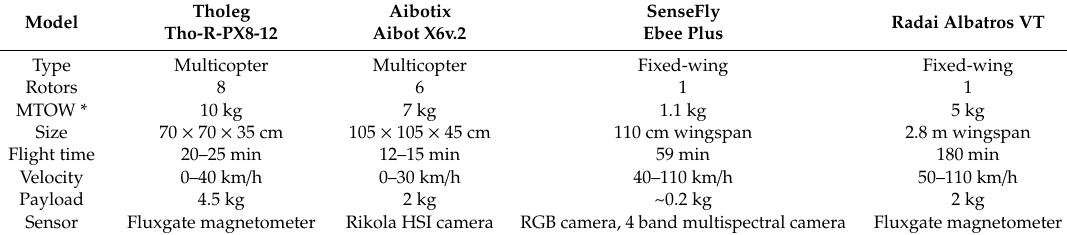
Figure 3. ( a ) Aibot UAS equipped with the HSI camera Rikola. ( b ) Tholeg UAS with a standalone MagDrone fluxgate magnetometer. ( c ) Radai’s Albatros fixed-wing UAS with a fluxgate sensor in the tail. Table 1. Technical details of the used UAS. The eBee plus instrument is not shown in Figure